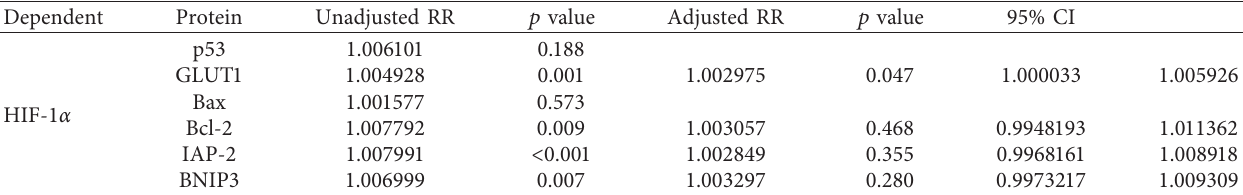
Table 2: Univariate Poisson regression analysis (unadjusted RR) between p53, GLUT1, Bax, Bcl-2, IAP-2, and BNIP3 with HIF-1 α and multiple analysis (adjusted RR) between GLUT1, Bcl-2, IAP-2, and BNIP3.